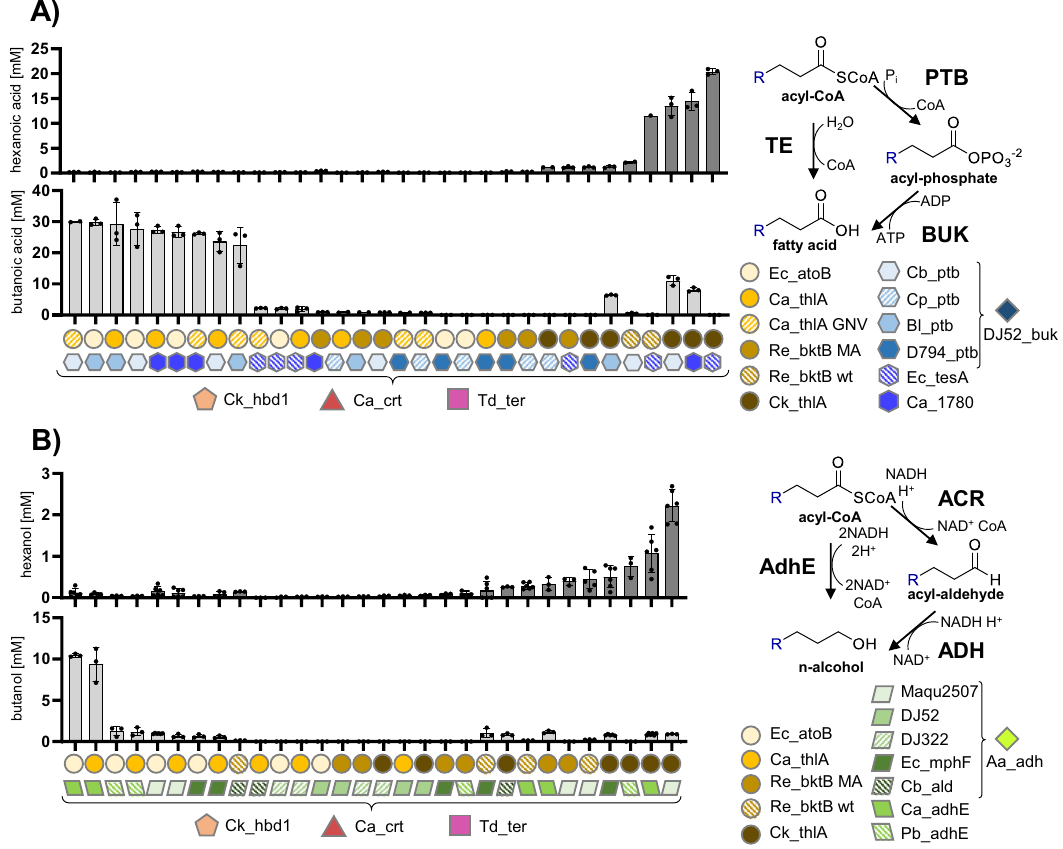
Fig. 3 In vitro screening of thiolase and termination enzymes to fi nd speci fi c variants for C4 and C6 products using the r-BOX core enzymes found in Fig. 2. A Thioesterase and ptb-buk termination screen for the production of short-chain fatty acids. All assays contained each enzyme at 0.3 μ M concentration. DJ52_buk was added to the enzymes containing ptb ’ s. B ACR-ADH and bifunctional AdhE screen for the production of butanol and hexanol. All assays contained thiolase and termination enzymes at 0.3 μ M concentration and the three core enzymes Ck_hbd1, Ca_crt, and Td_ter at 0.15 μ M due to volume limitations. Assays with an ACR were complemented with 0.15 μ M of Aa_adh. All measured data points and their mean are shown with n greater than or equal to 3, and error bars represent standard deviation. Detailed results and full information on enzyme abbreviations in Source Data fi